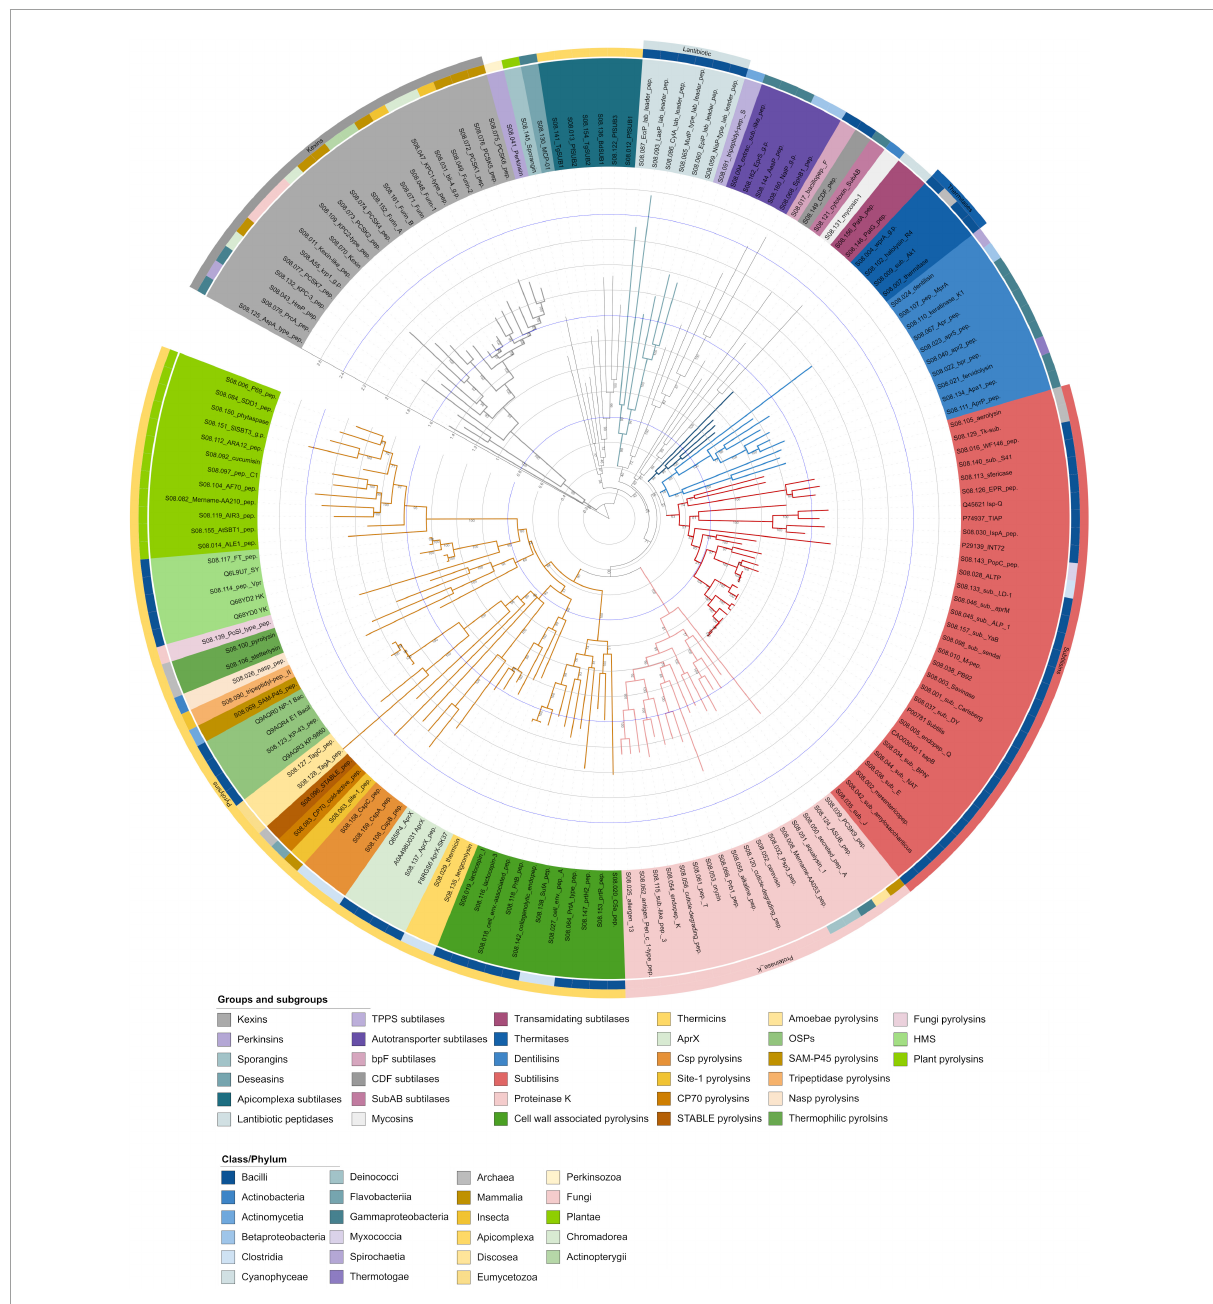
FIGURE2 MEROPS S8 holotype phylogenetic tree. Phylogenetic relationship of S8 groups and subgroups using the mature protease sequences. The tree was constructed with IQ-TREE by employing the maximum likelihood method with ultrafast bootstrap support (model: LG + I + G4, predicted by Modelfinder, 1,000 replicates). The coloured range within the labels represents the subgroups as shown within the legend. The circles around the phylogenetic tree represent the class or phylum from which the holotype originates, marked by different colours. The kexin proteases S8B were selected as the outgroup. The outer ring represents the group classification after Siezen and Leunissen (1997). For each clade, the numbers above the branches indicate the bootstrap values based on 1,000 repetitions. The tree can be accessed under the following link: